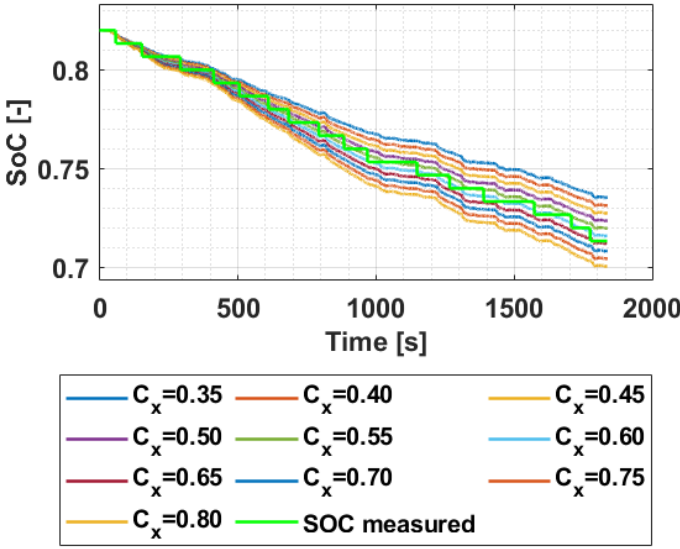
Figure 17. Comparison of the battery state of charge trajectories estimated by the model considering different drag coefficients with respect to the experimental battery state of charge of DM25.